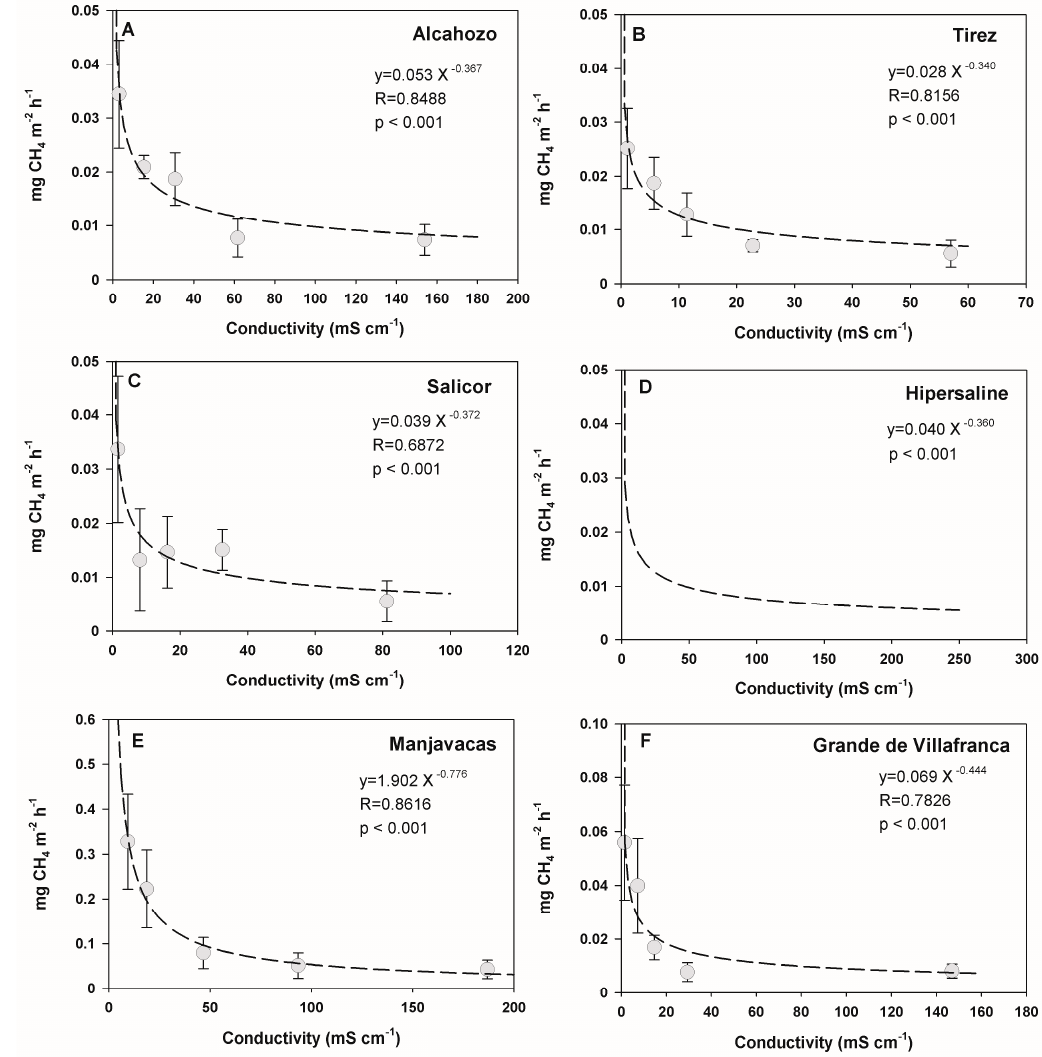
Figure 4. Changes in methane release rates vs. salinity (with water electrical conductivity as a proxy) for the studied lakes. Bars represent the standard deviation.